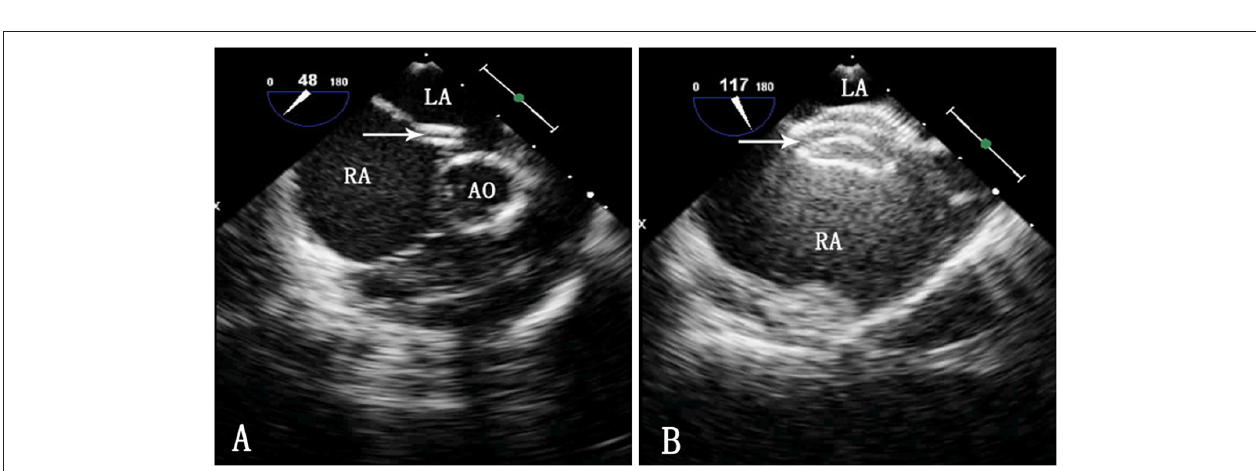
FIGURE 2 | TEE image during ASD occlusion. LA, left atrium; RA, right atrium; Ao, aorta. (A) Passing of the sheath through the ASD. The arrow indicates the delivery sheath. (B) Morphology of the occluder after release. The arrow indicates the